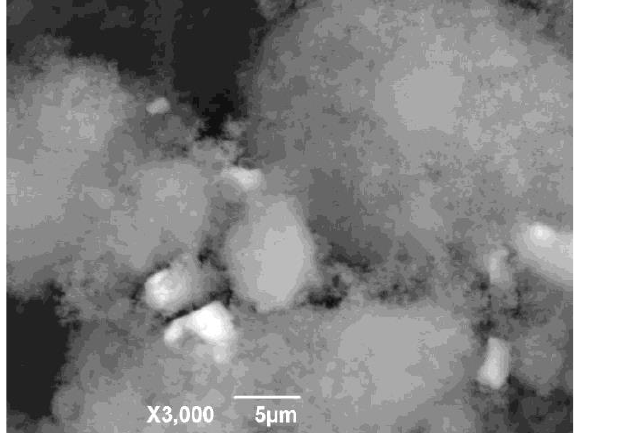
Table 9. Comparison with standard requirements of SiO 2 obtained by precipitation from silicate solution followed by water washing and drying at 250 °C, wt.%. Attribute